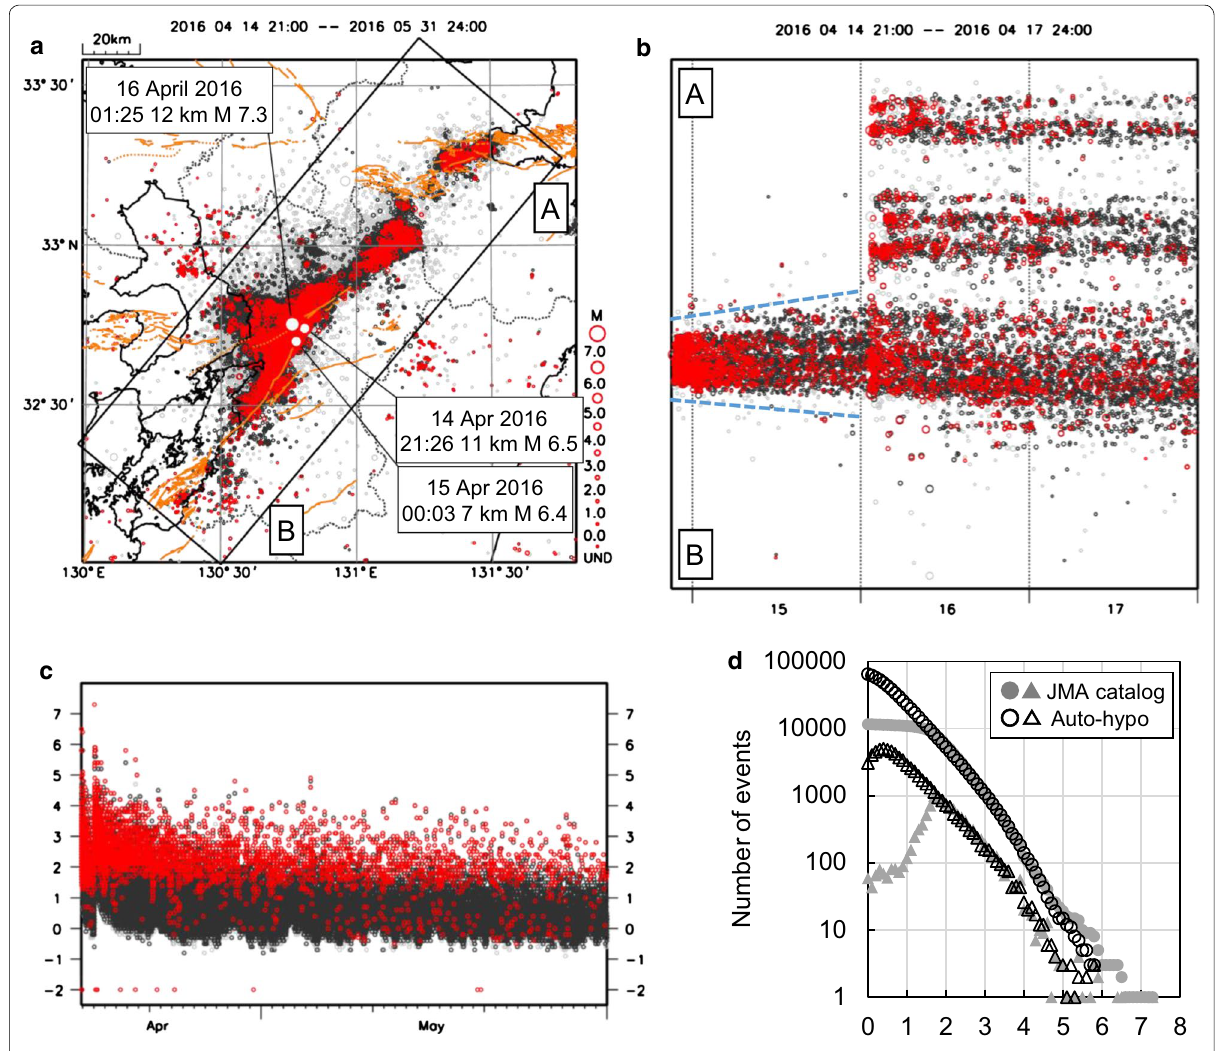
Fig. 7 Hypocentral distribution and frequency–magnitude distribution of the 2016 Kumamoto earthquake sequence for events shallower than 50 km (21:00 April 14–24:00 May 31, 2018; depth range 0–50 km). a Epicentral distribution (21:00 April 14 to 24:00 May 31, 2018). b Spatiotemporal distribution (21:00 April 14–24:00 April 17, 2018) projected onto line A–B in a . c Magnitude–time diagram (21:00 April 14–24:00 May 31, 2018). Red dots along the bottom indicate events whose magnitude undefined. Red, black, and gray dots indicate events in the JMA unified catalog (as of June 6, 2016), high-quality automatically processed hypocenters (time error within 0.2 s and horizontal error within 0.5 ′ ), and all automatically processed hypocenters, respectively. d Frequency–magnitude distribution of events related to the 2016 Kumamoto earthquake. Solid symbols indicate events in the JMA unified catalog, and open symbols indicate automatically processed hypocenters. Circles and triangles indicate cumulative and incremental frequencies,